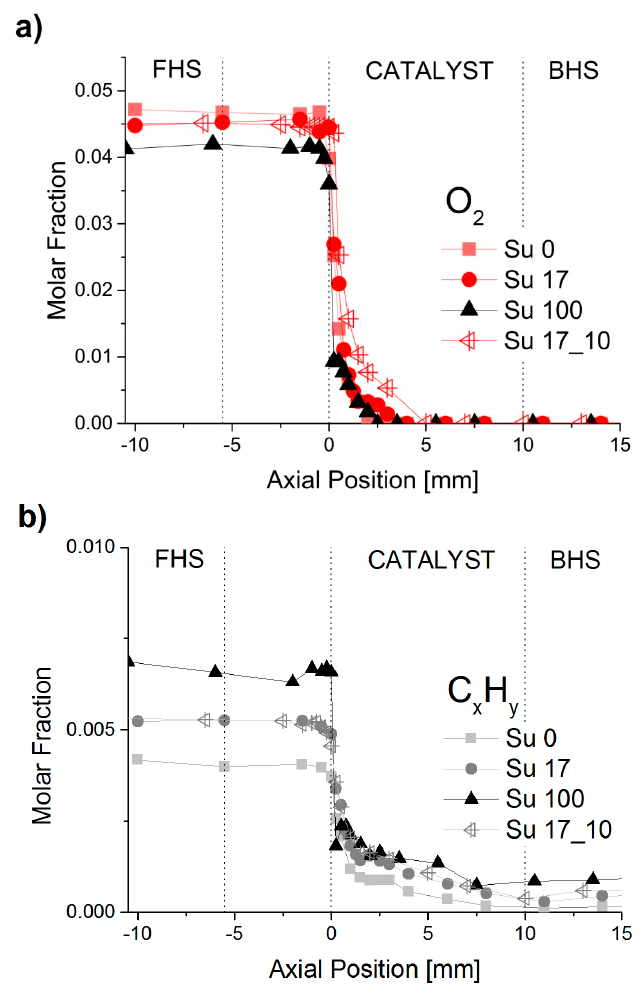
Figure 3. Molar fraction of the reactants oxygen ( a ) and fuel ( b ) as function of the axial coordinate z for the Rh catalyst ( z = 0–10 mm) for the CPOX of different surrogates. The molar fraction of oxygen for Su 17_10 was calculated based on oxygen balance. Along the axial coordinate, the location of the front heat shield (FHS), the catalyst, and the back heat shield (BHS) is indicated.